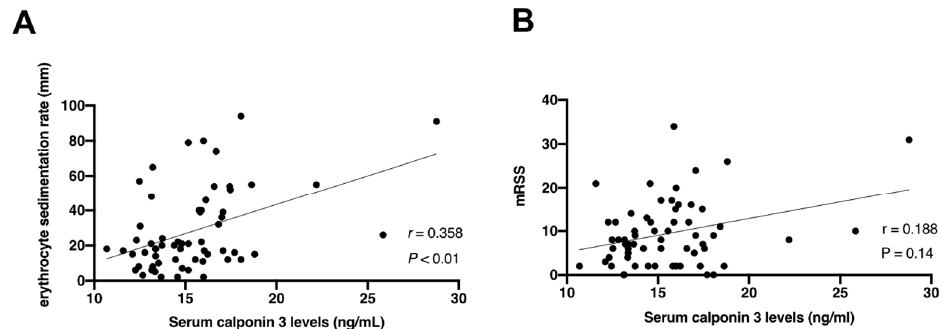
Figure 2. Correlation between serum calponin 3 levels with ( A ) erythrocyte sedimentation rate and ( B ) modified Rodnan total skin thickness score (mRSS) in systemic sclerosis. The solid line shows the regression line. Spearman’s rank correlation coefficient (r) was calculated for correlation analysis. Table 1. Clinical features of SSc patients stratified by serum calponin 3 levels.